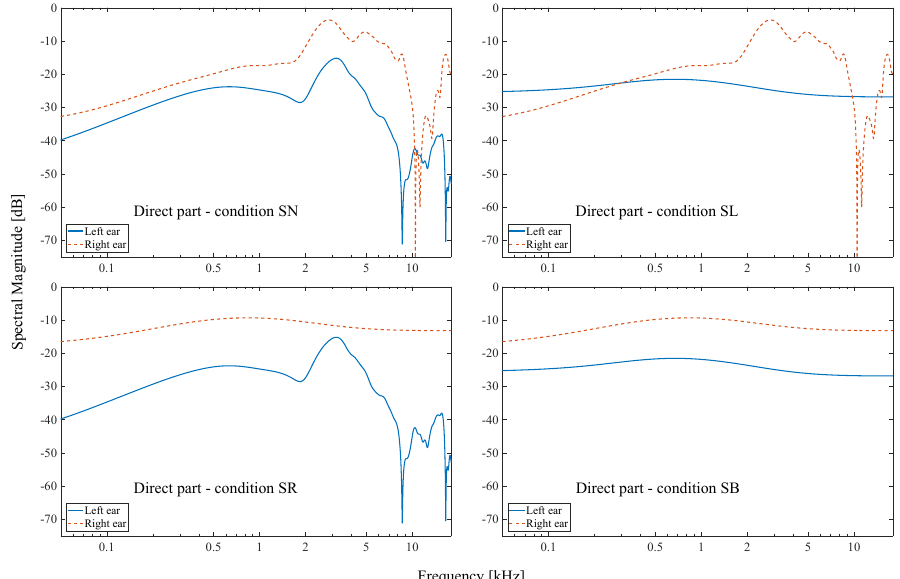
Figure 3. Examples of magnitude spectra for the direct part of the BRIR at 60° for the “SN”(left top), “SL” (right top), “SR” (left bottom), and “SB” (right bottom) conditions. The solid and dashed curves denote the magnitude spectra for the direct part in the BRIR of left and right ears,